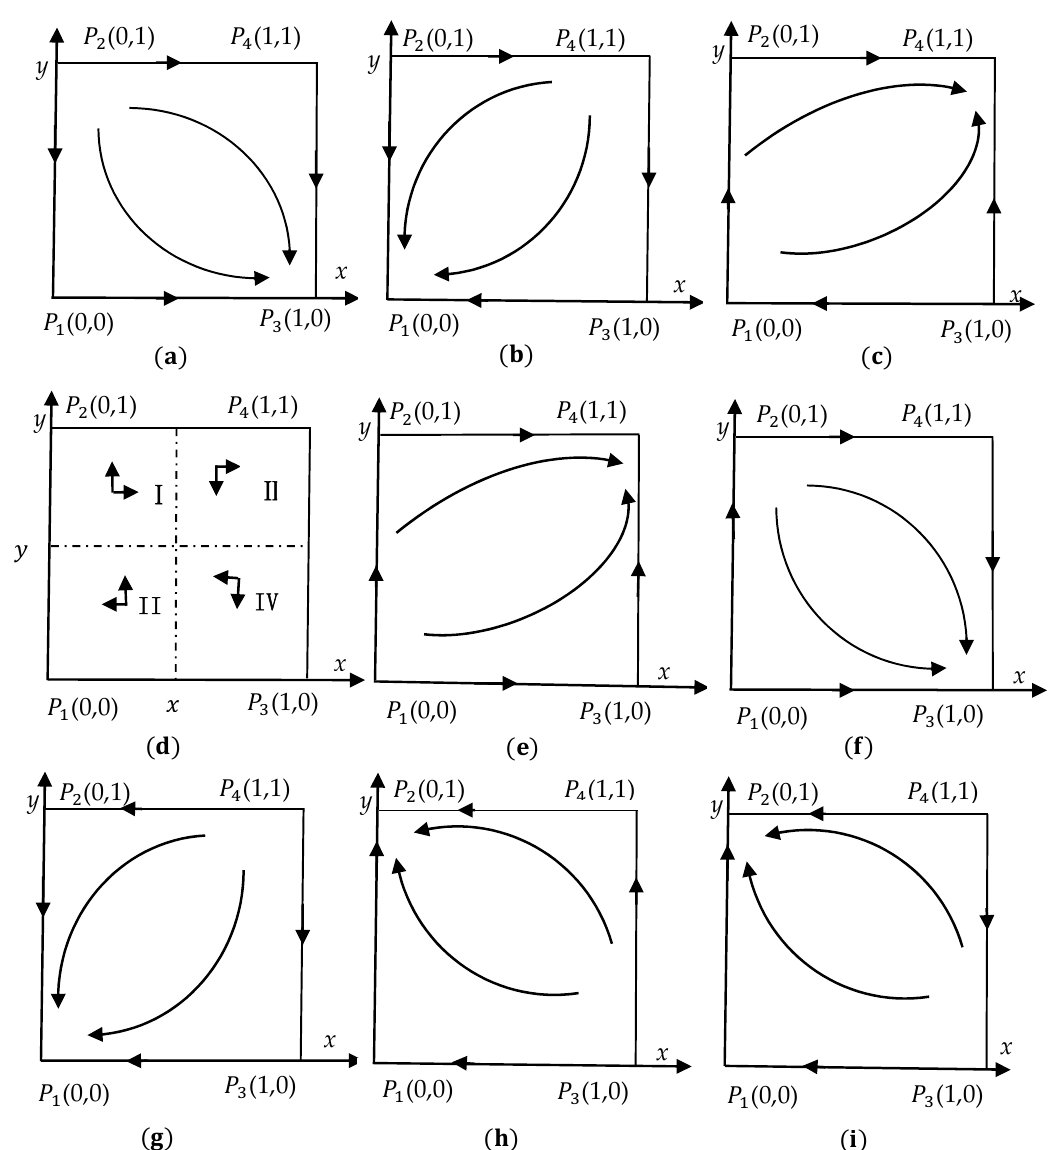
Figure 1. Dynamic phase diagram of system evolution under nine situations. Note: Figures ( a – i ) refers to the figure number of dynamic phase diagram of system evolution under situation